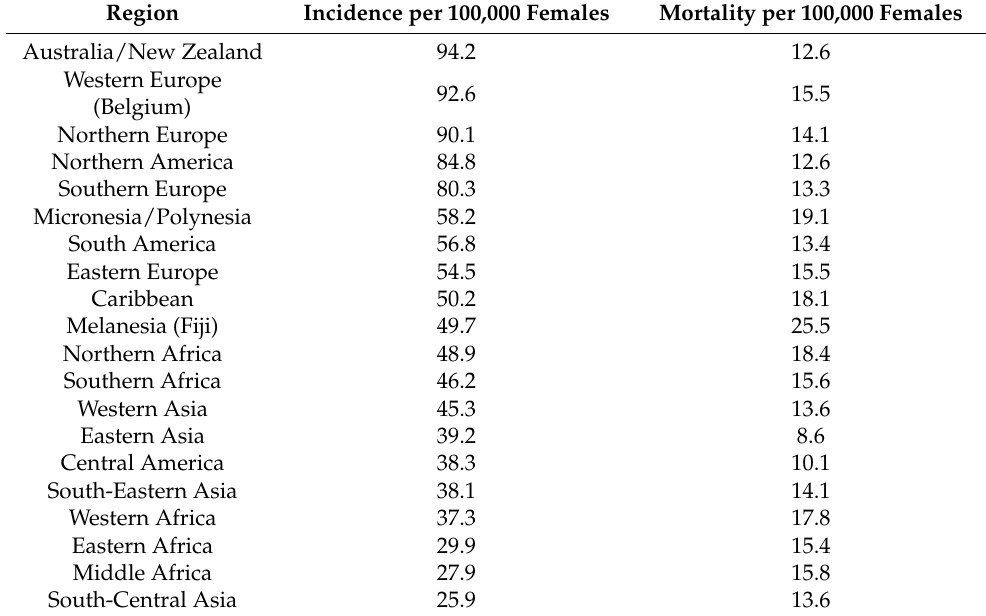
Table 1. Source: GLOBOCAN 2018.